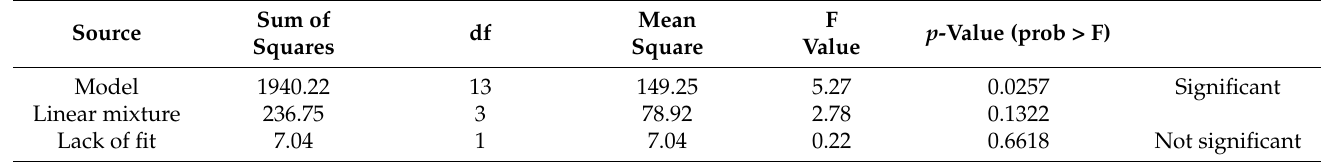
Table 1. ANOVA analysis of variables tables.